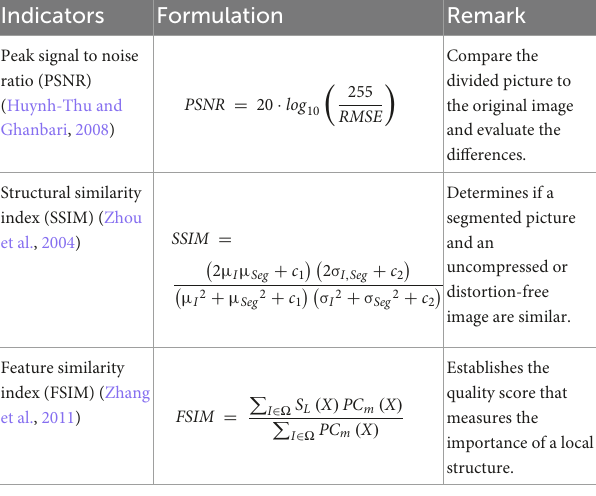
TABLE 3 Indicators of the multi-level image segmentation techniques’ performance.